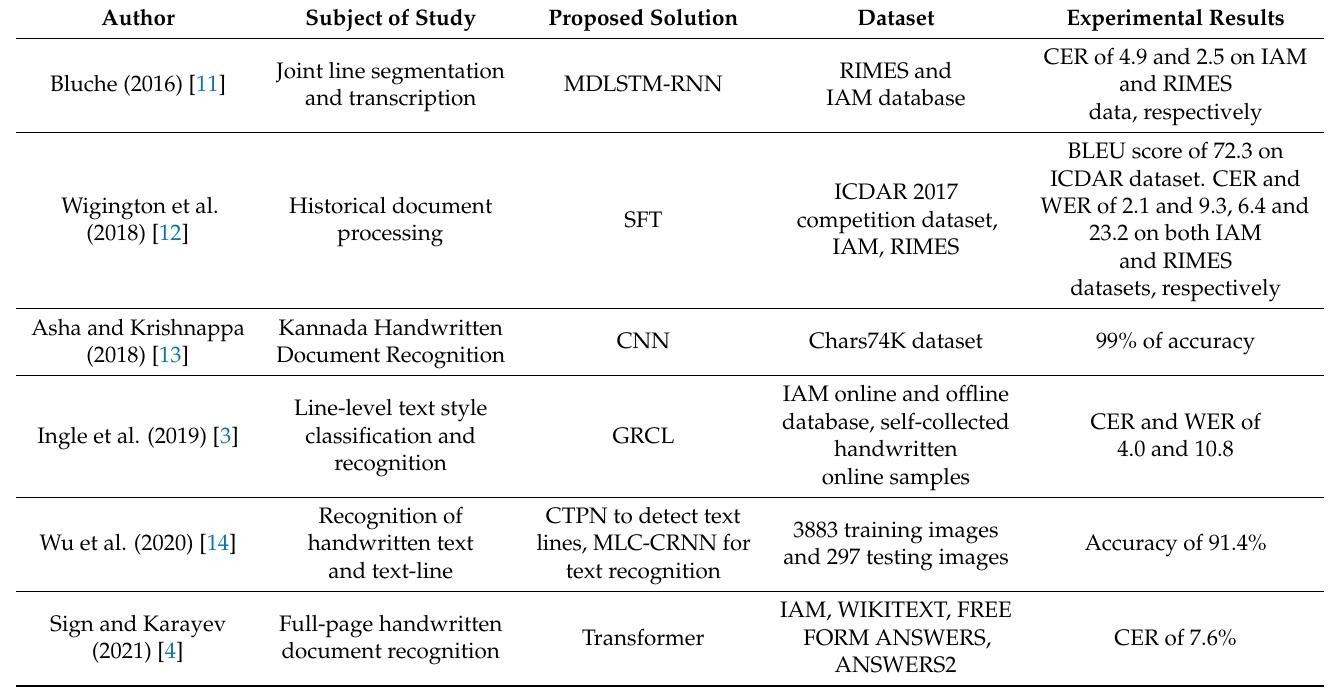
Table 1. Summary of included